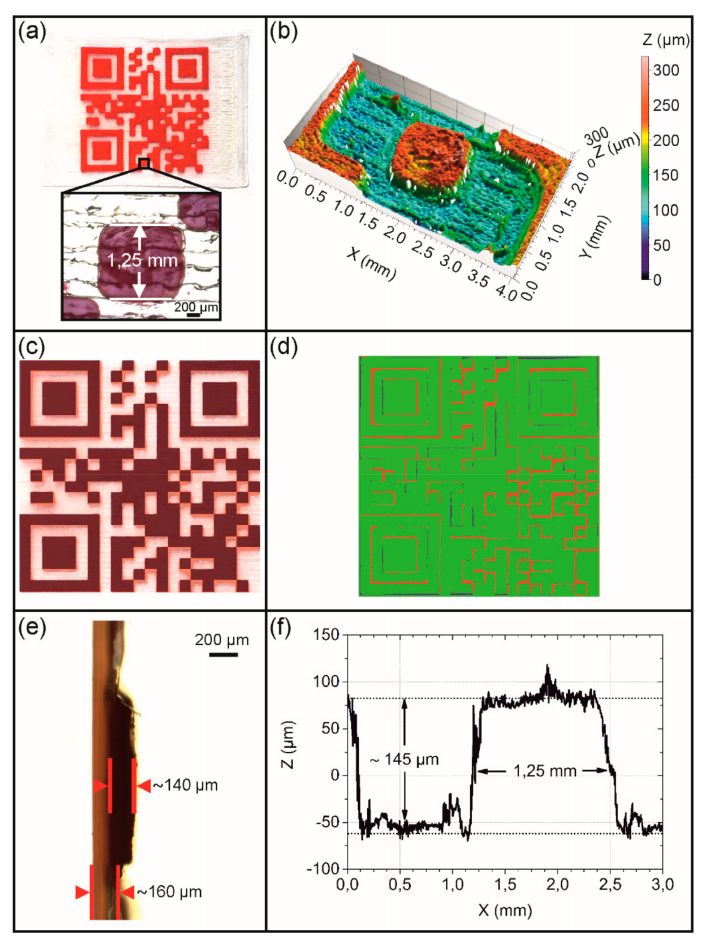
Figure 5. Type 1 QR code carrier as investigated by light and confocal microscopy including an evaluation of print quality: Top view and inset exhibiting a randomly selected cuboid ( a ), surface topography of the cuboid and its surrounding ( b ), superposition with a virtual QR code having a transparency of 60% ( c ), result of a mathematic calculation to determine the congruence of the virtual QR code with the physical print object: consistent print areas (green color), irregularly filled areas (red color) and unfilled print areas (blue color) ( d ), side view of a cut through the cuboid and the substrate ( e ), and the evolution of layer thickness Z with regard to the cuboid and its surrounding ( f